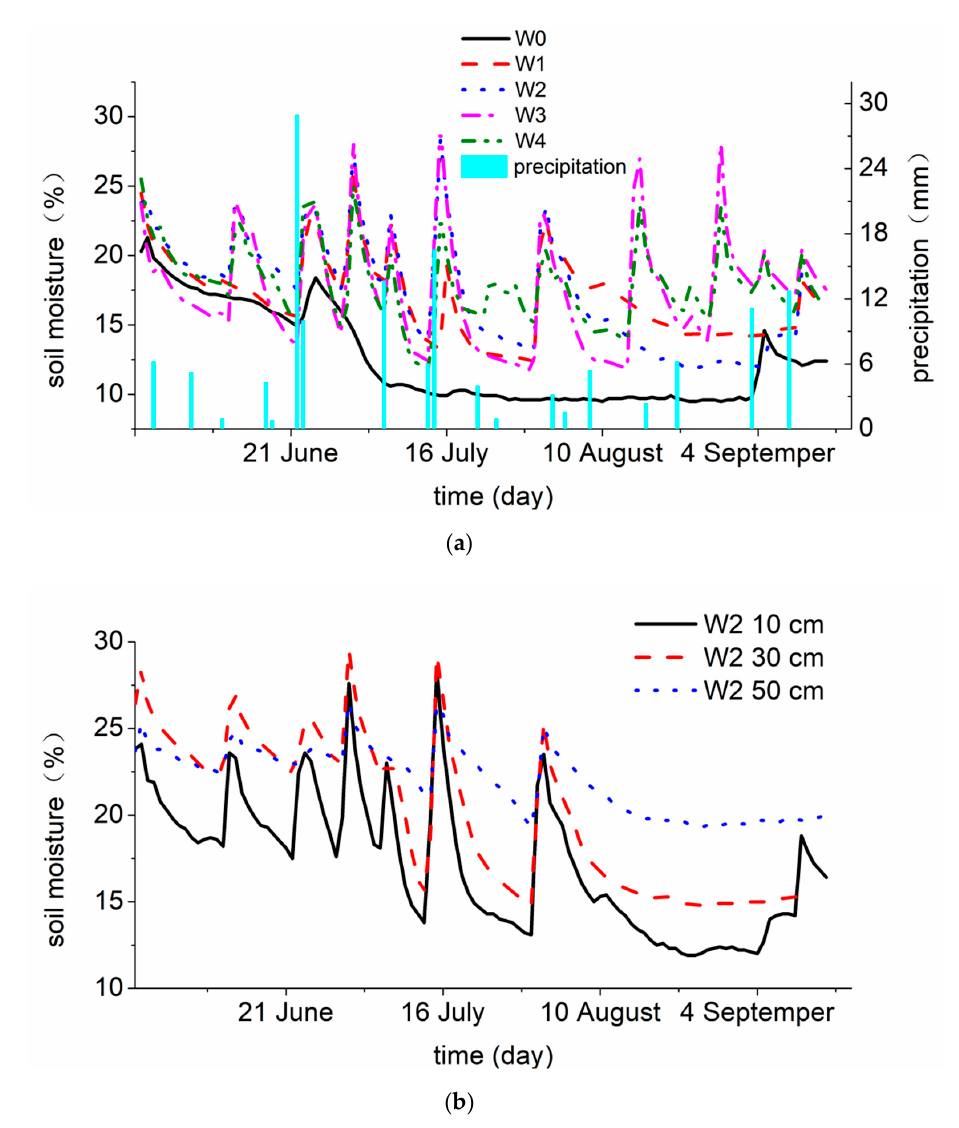
Figure 5. The change characteristics of the average soil moisture under ( a ) different treatments, and ( b ) different depths.